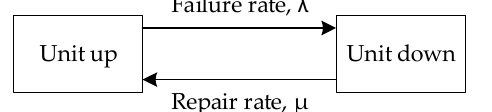
Figure 4. Operating cycles of all considered generating units. A system load is also generated using a load model expressed by Equation (3). Since the uncertainties of load data are caused by errors of load forecast, the load model is then built from the forecasted load values with their errors. 𝐿 (cid:3047) = 𝐿 (cid:3047) (cid:3033)(cid:3042)(cid:3045)(cid:3032)(cid:3030)(cid:3028)(cid:3046)(cid:3047) + 𝜎 (cid:3013),(cid:3047) 𝑍